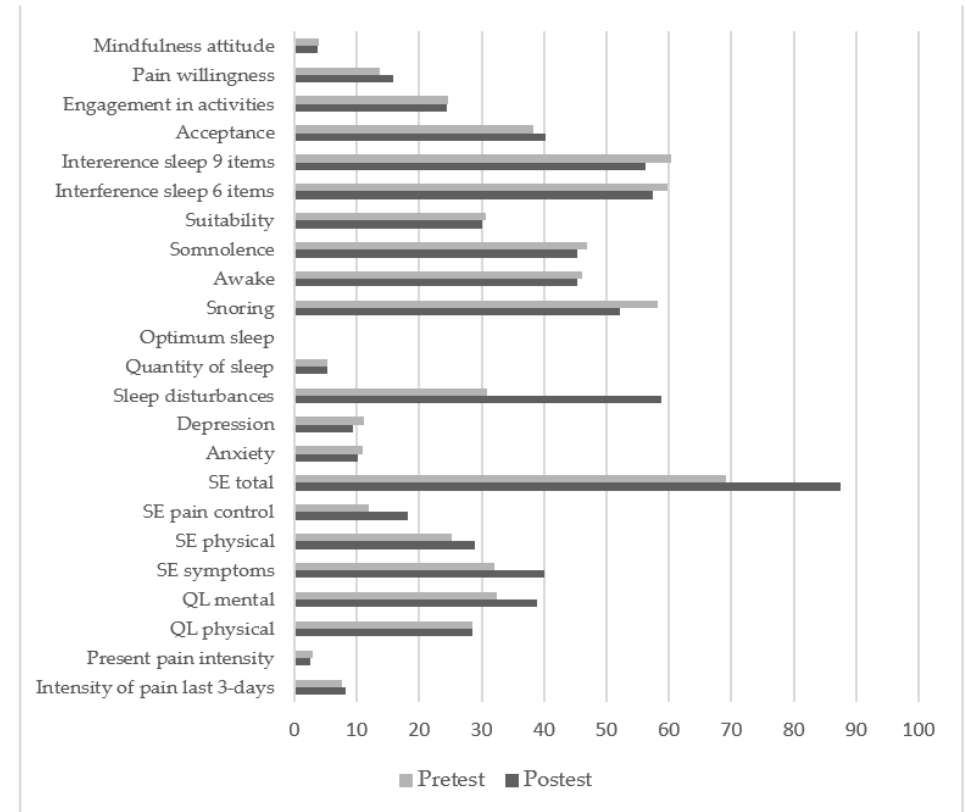
Figure 2. Means before and after the treatment for all the variables. QL = quality of life; SE = self- efficacy.